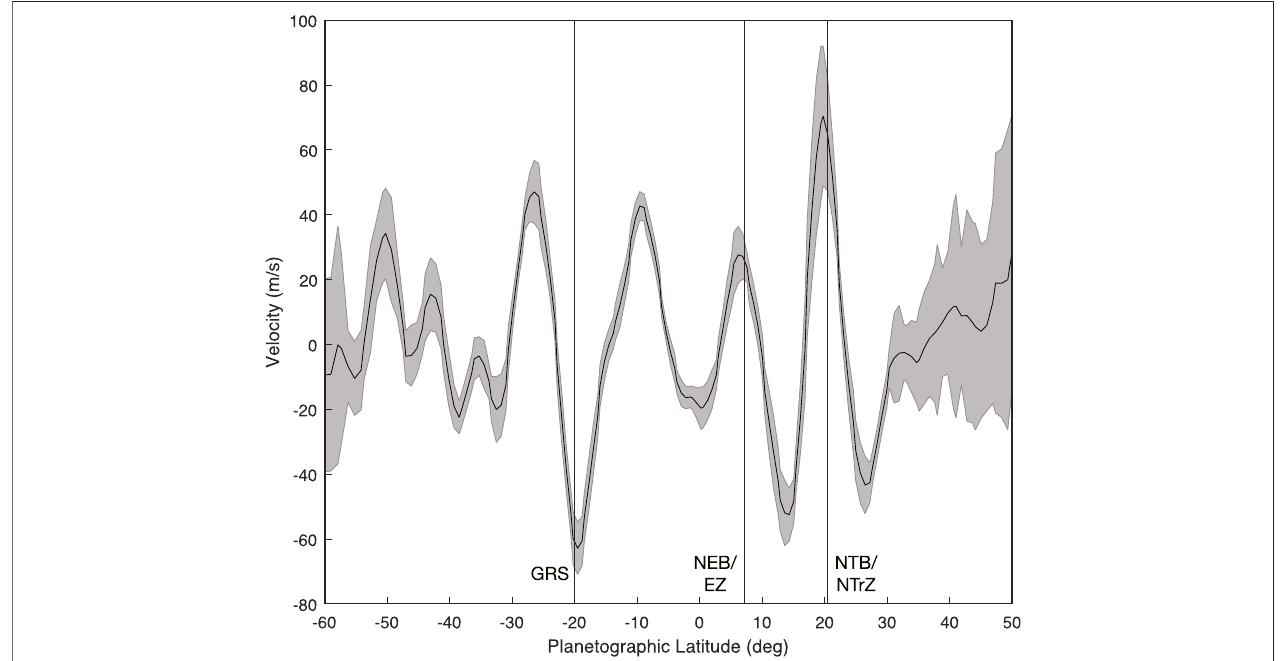
FIGURE 8 | The average (high-pass fi ltered) Doppler velocimetric zonal wind pro fi le of Jupiter derived from the 2020 observational campaign. The pro fi le is plotted as a black line with error bars displayed as the surrounding transparent grey region. The locations of prominent region interfaces of interest (the GRS, NEB/EZ interface, and NTB/NTrZ interface) are marked with vertical lines. Positive velocity corresponds to the prograde direction and negative velocity corresponds to the retrograde direction.